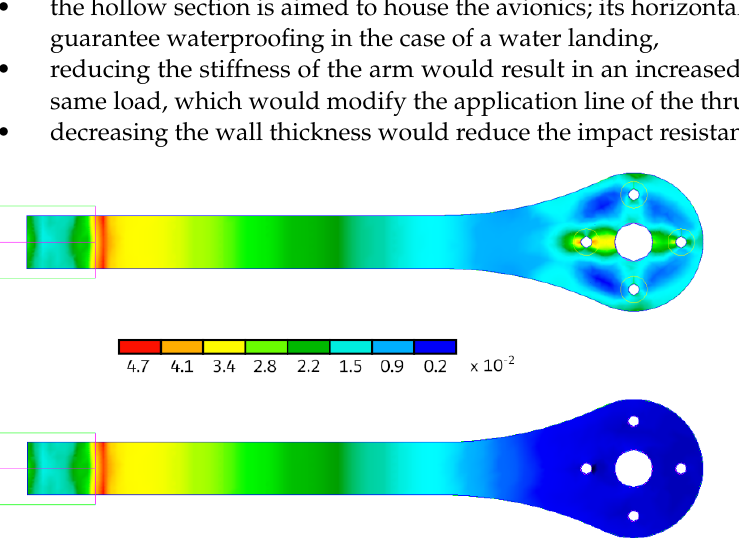
Figure 18. Failure indices in the top and bottom surfaces of the arm; Maximum Stress Criterion.